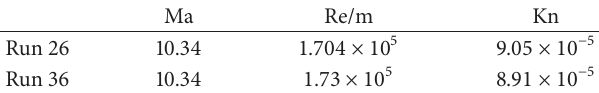
Table 3: Flow conditions for Run Numbers 26 and 36.